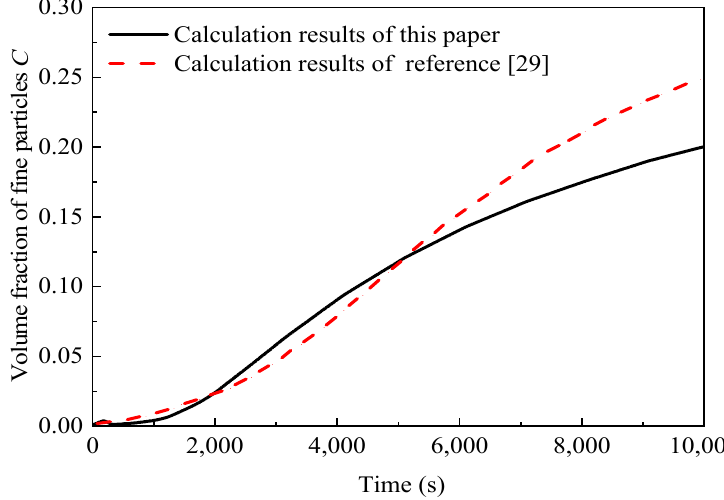
Figure 4. Evolution curves of the volume fractions of fine particles at inner boundary.